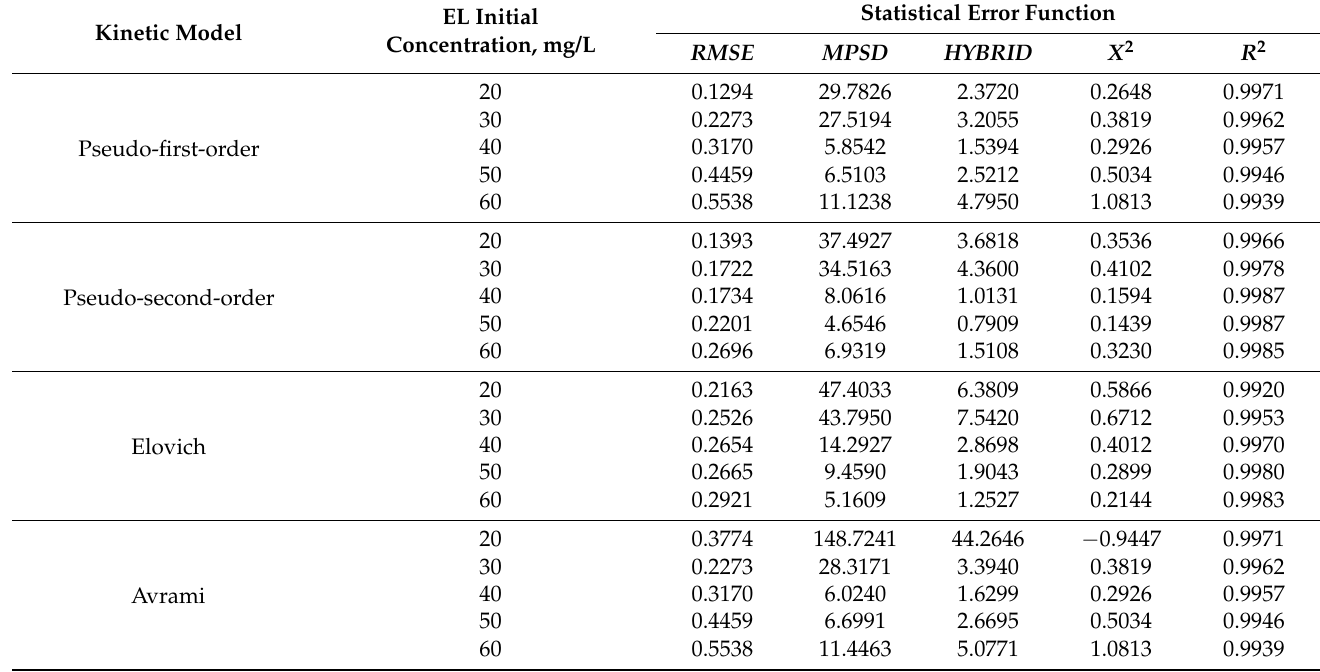
Table 7. Statistical error functions of estimated kinetic nonlinear models for the biosorption process conducted on SPRBA 5%